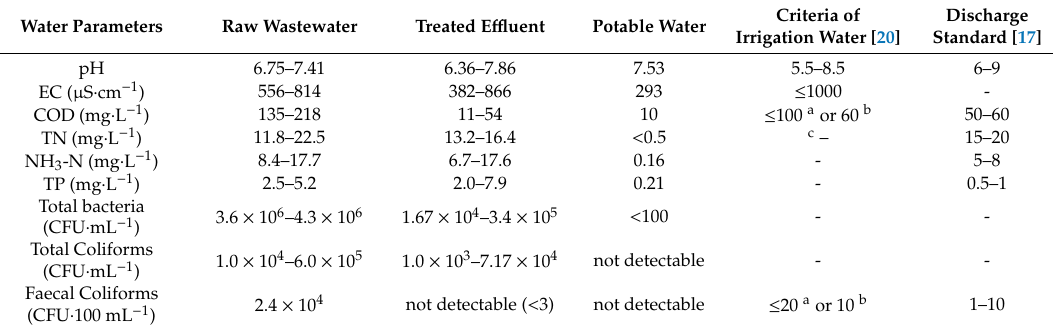
Table 1. Operation parameters of raw domestic wastewater and treated e ffl uent.